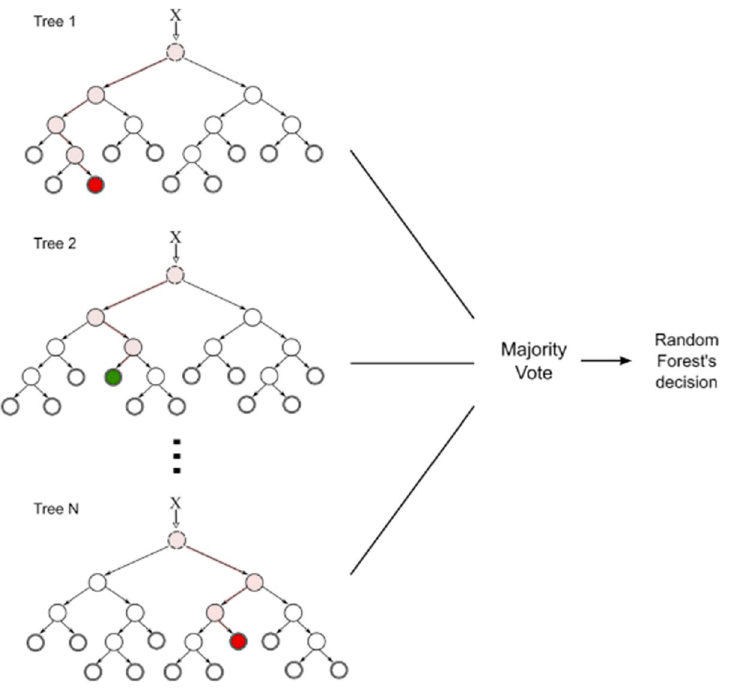
Fig 3. Architecture of Random Forest